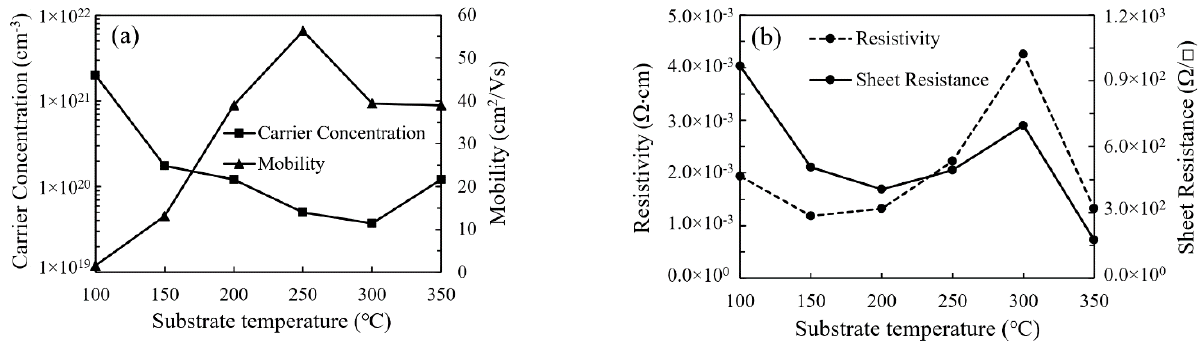
Figure 11. The variation of ( a ) the carrier concentration, mobility and ( b ) resistivity of In 2 O 3 films with substrate tempera- ture.